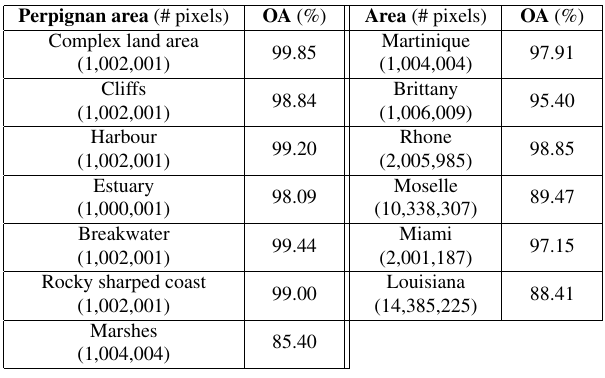
Table 2: Overall Accuracy (OA) for areas introduced in Section